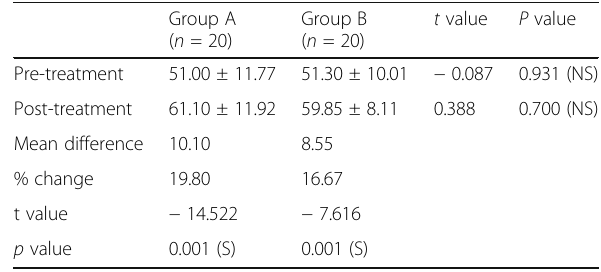
Table 2 Comparison of mean scores of VAS within and between both groups